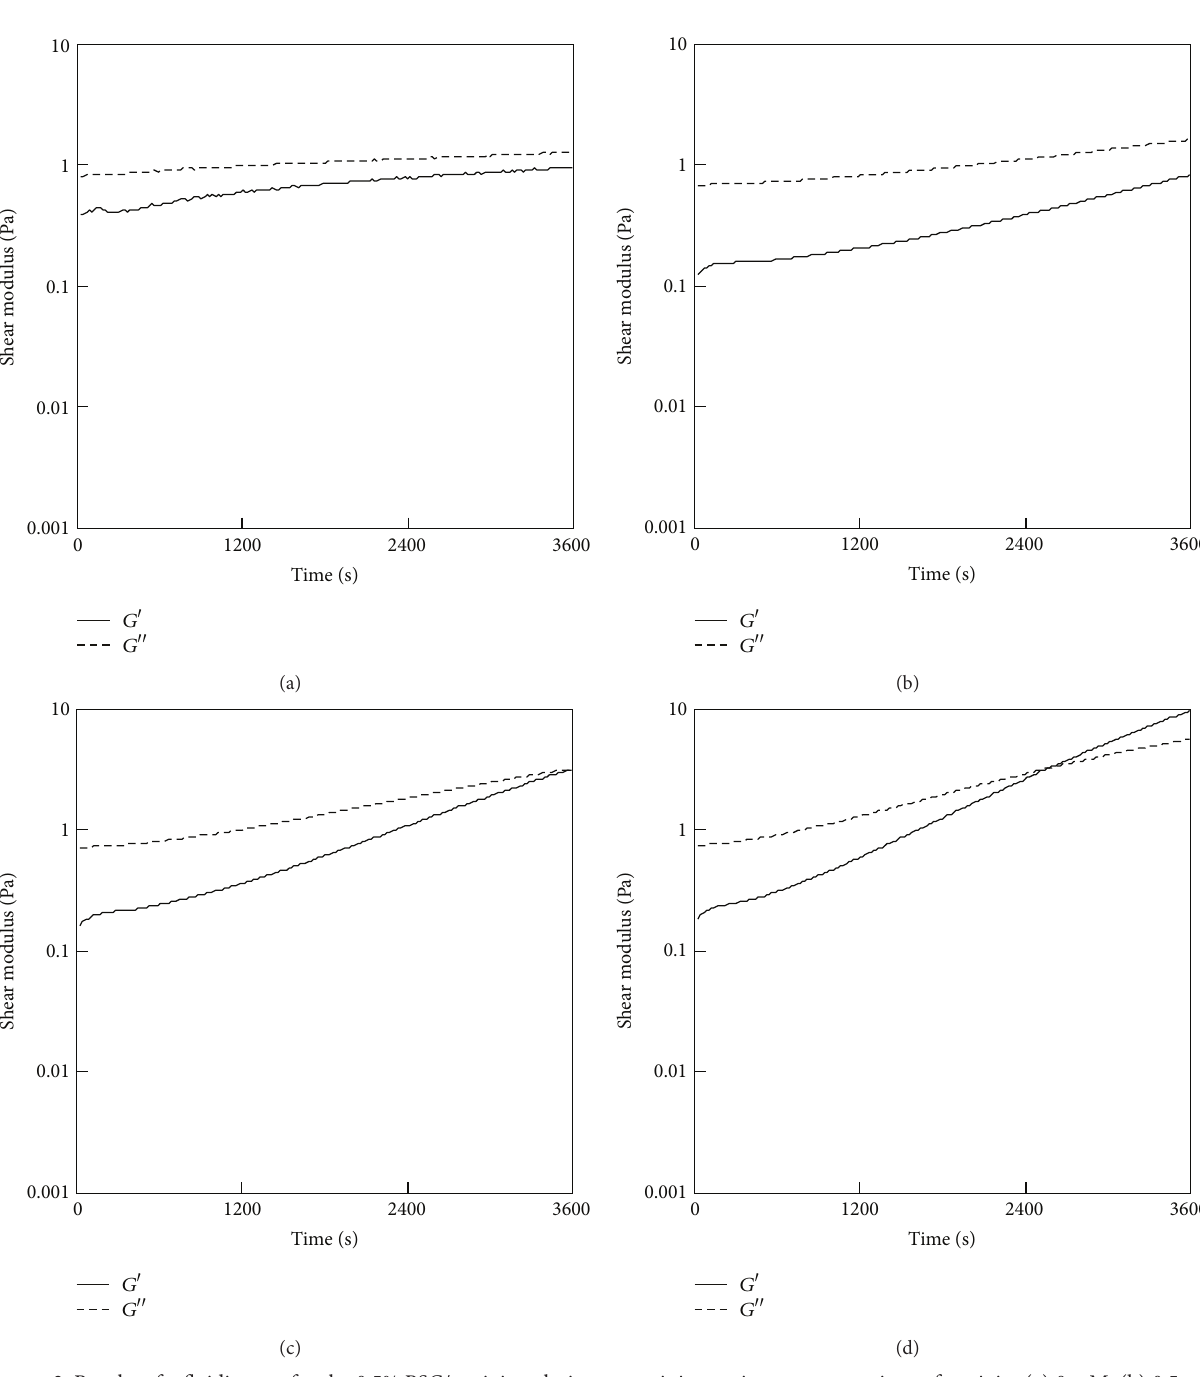
Figure 2: Results of a fluidity test for the 0.5% PSC/genipin solutions containing various concentrations of genipin: (a) 0mM, (b) 0.5mM, (c) 1mM, or (d) 2 mM. Temperatures were maintained at 25 ∘